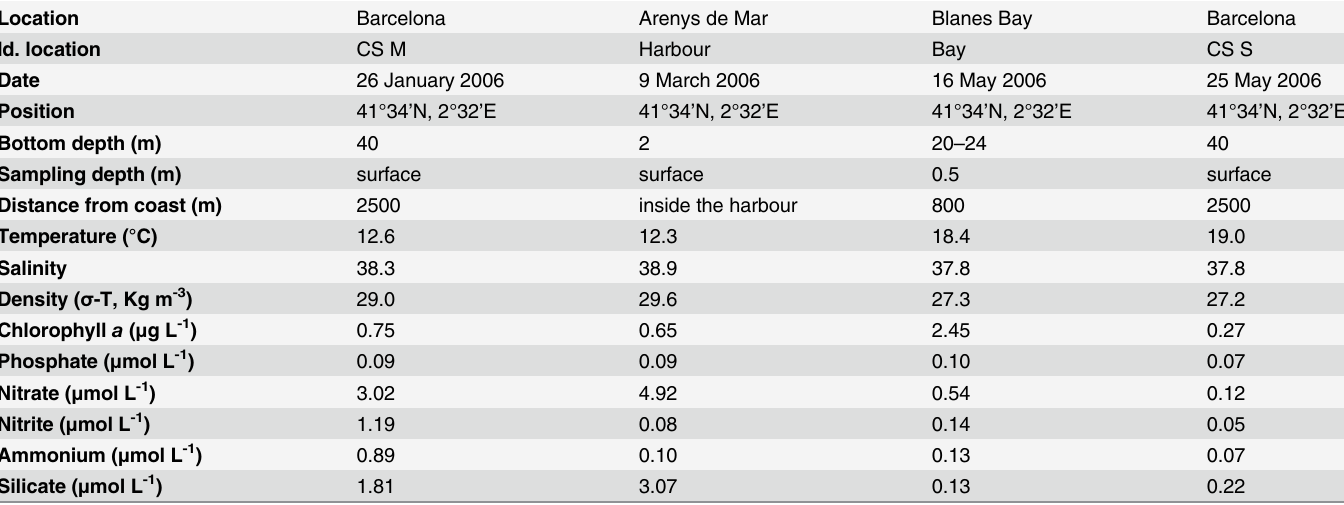
Table 1. Physical and biogeochemical characteristics of the different sampling